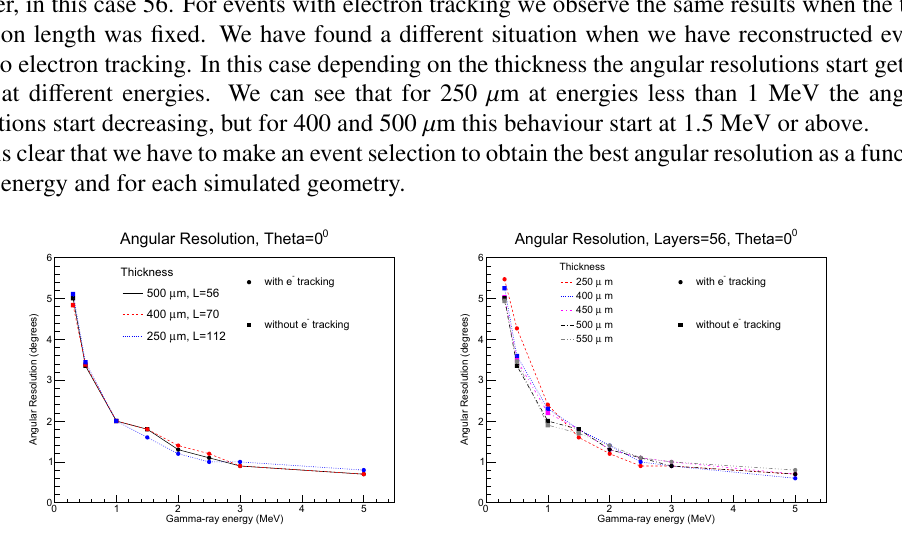
Figure 4: Angular resolution, after event selection, from the reconstruction of Compton events, Left panel: Fix the radiation length. Right panel: Fix the number of layers.